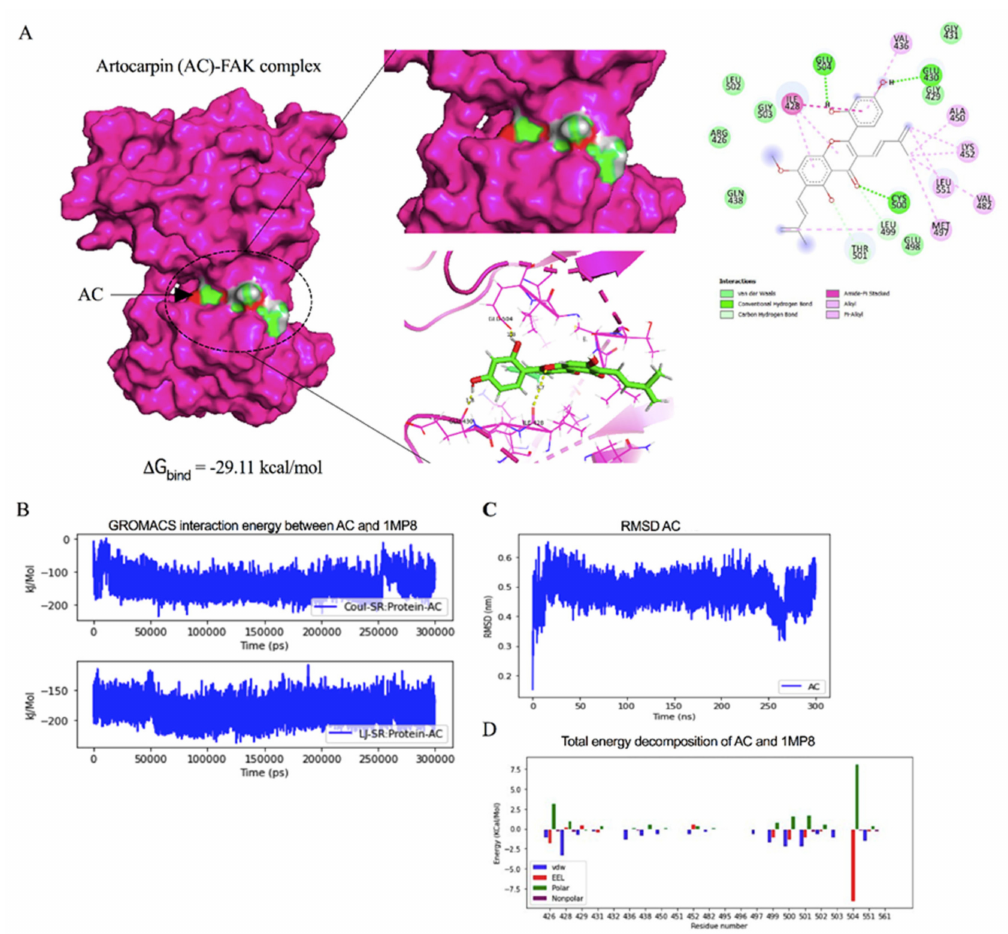
Figure 6. Docked model depicting interaction of artocarpin (AC) with FAK protein. ( A ) Binding mode and docking energy of AC bound to the binding site of FAK taken from the MD study. ( B ) The GROMACs interaction energy between artocarpin (AC) and FAK (1MP8). ( C ) The RMSD plot for interaction of artocarpin-FAK complex during 300 ns of molecular dynamic simulation. ( D ) Total energy decomposition of artocarpin-FAK complex using the gmx_MMPBSA